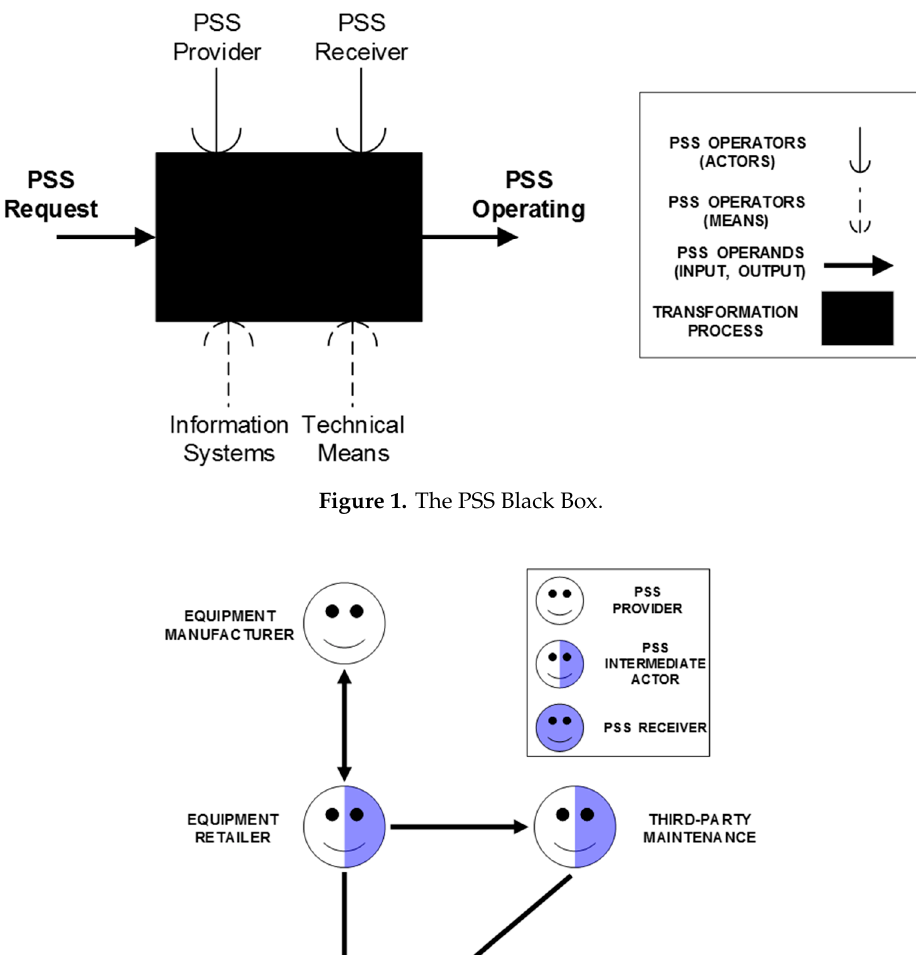
Figure 1. The PSS Black Box.